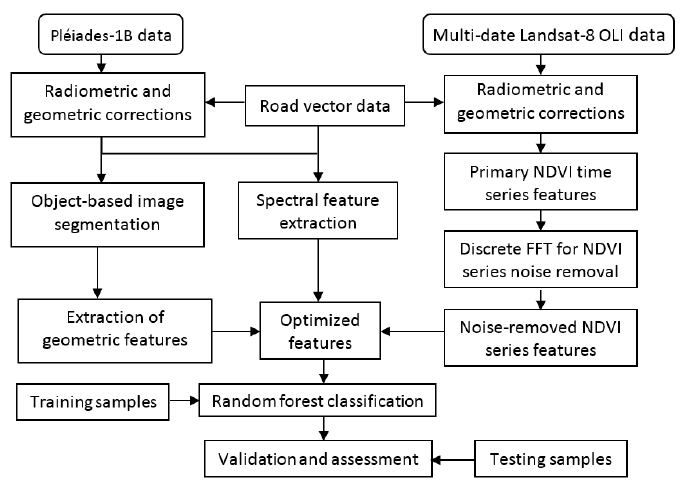
Figure 3. The flowchart for the random forest classification of the wetland. OLI: Operational land imager; NDVI: normalized difference vegetation index; FFT: fast Fourier transform